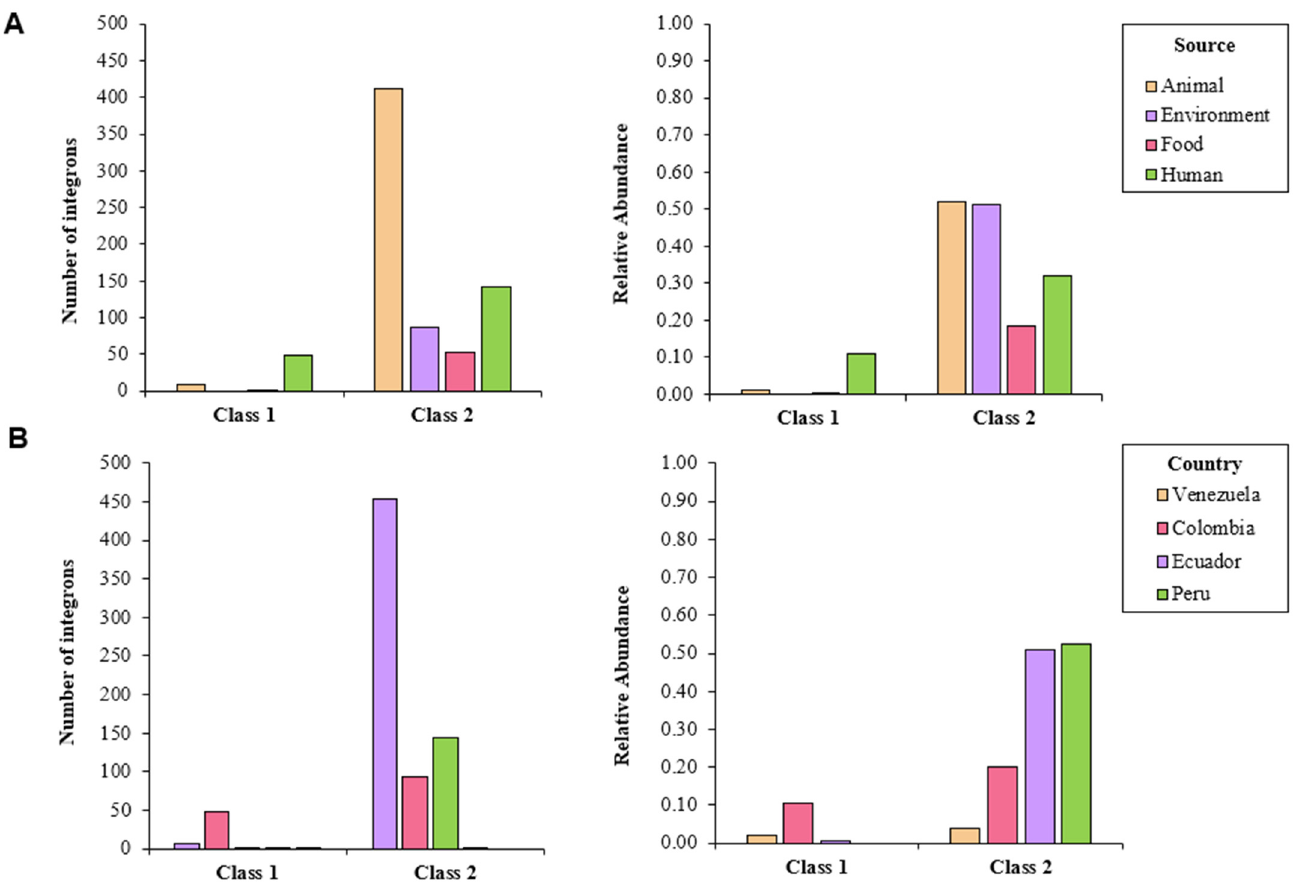
Figure 1. Number of detected integrons in whole-genome sequenced isolates of S. enterica according to IntFinder 1.0, classified by ( A ) source and ( B ) country.